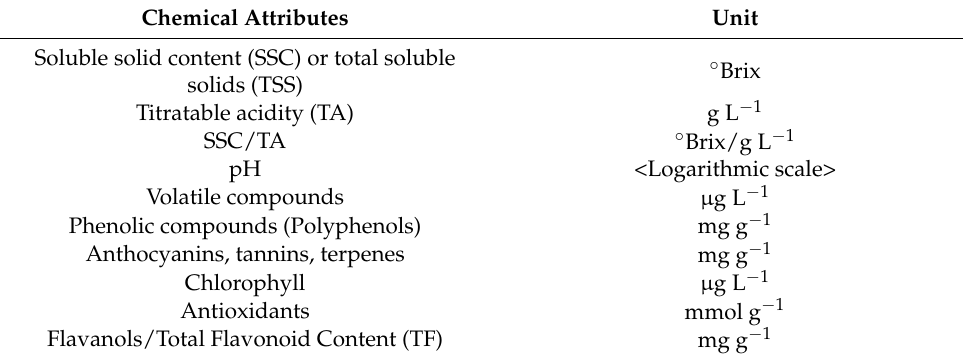
Table 1. List of chemical attributes used as maturity